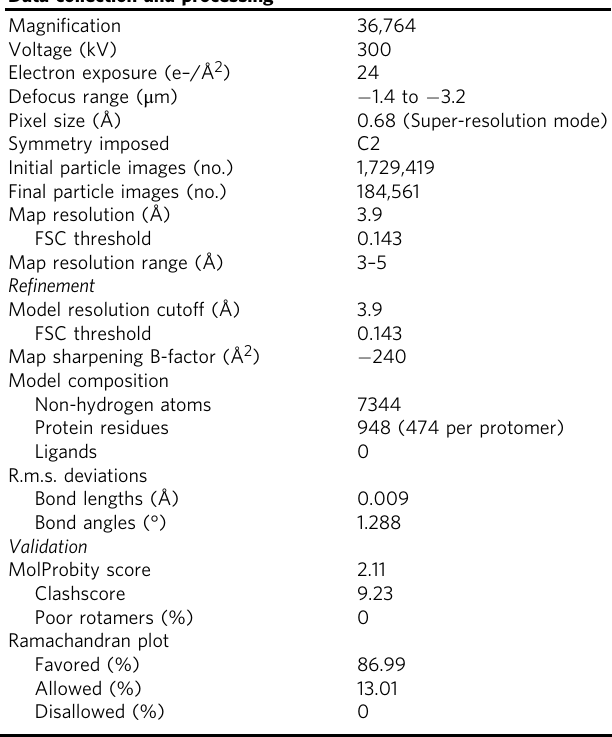
Table 1 Cryo-EM data collection, re fi nement, and